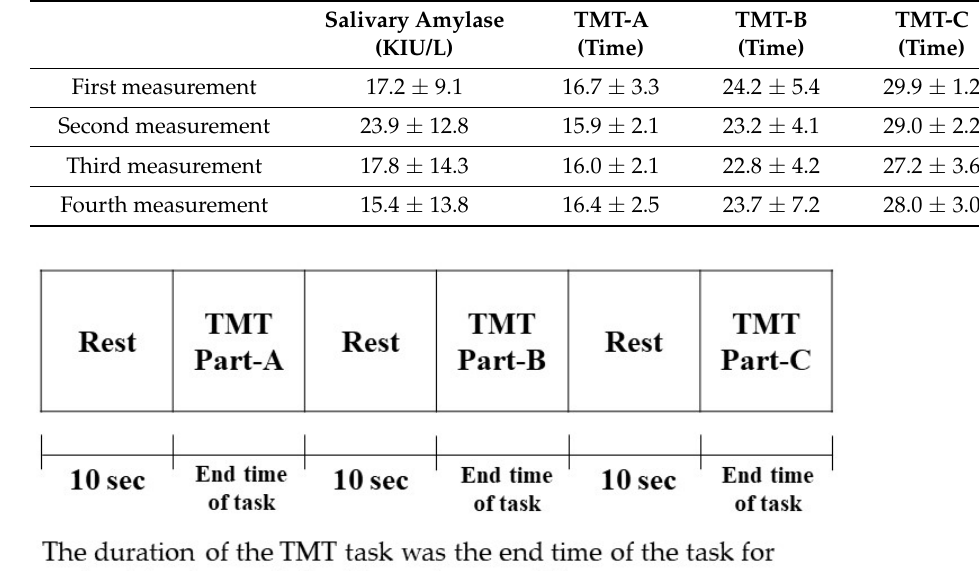
Figure 1. Measurement